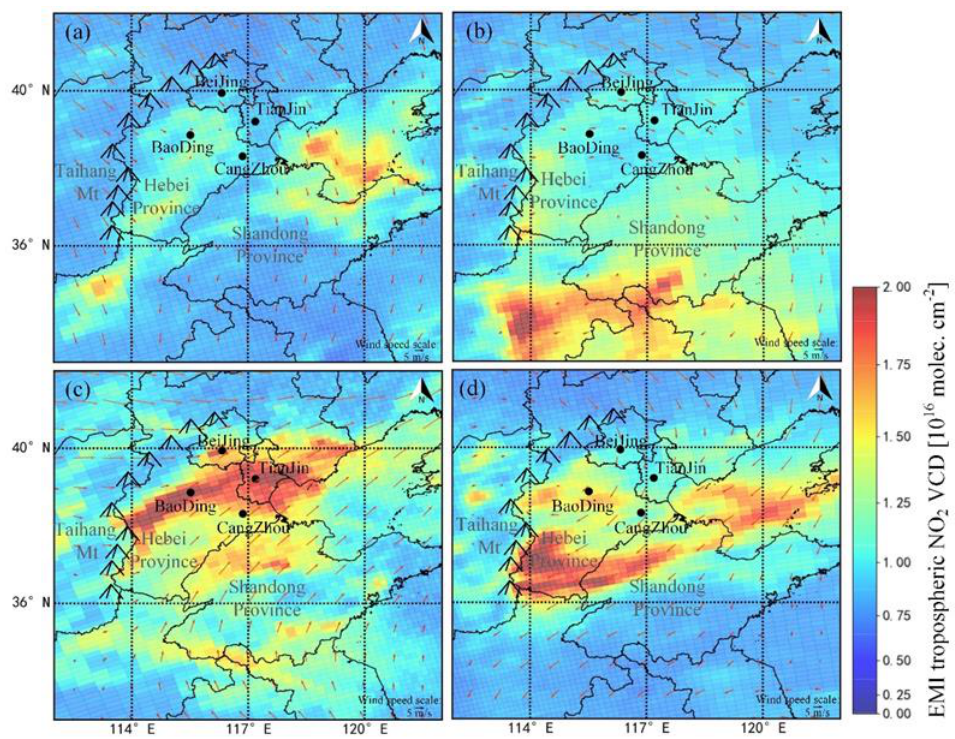
Figure 10. Tropospheric NO 2 distribution of the EMI and the wind field (red arrows) on ( a ) 22 De- cember 2018, ( b ) 23 December 2018, ( c ) 24 December 2018, and ( d ) 25 December 2018.